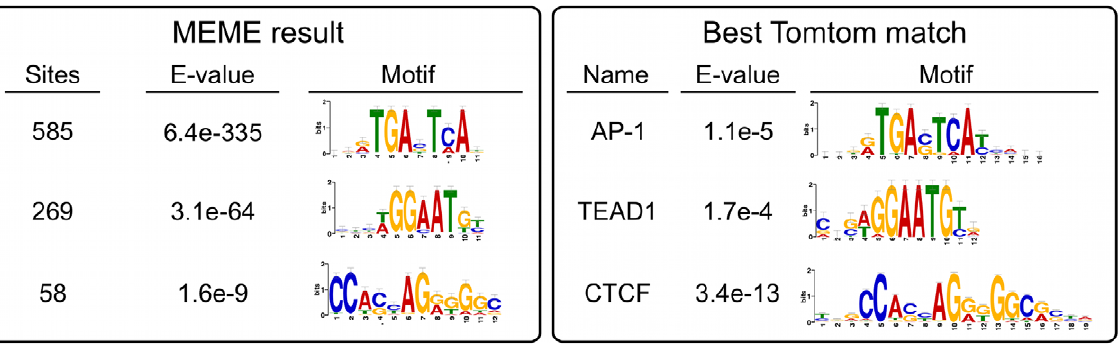
Figure 7. Non-MER85 peaks are enriched for TRE, TEAD1, and CTCF binding site motifs. ( left ) Analysis using Multiple Em for Motif Elicitation (MEME). Sequences within 50 bp of non-MER85 peak summits were submitted to MEME to identify overrepresented motifs. ( right ) Analysis using Tomtom motif comparison tool. Position specific frequency matrices for the motifs identified by MEME were submitted to TOMTOM to identify matching transcription factor binding sites. The most significant matches for each result are shown. *AP-1 motif was annotated jundm2_secondary, Jun dimerization protein 2 secondary motif (UniPROBE mouse database); TEAD1, TEA domain family member 1 (JASPAR core 2009 database); CTCF, CCCTC binding factor (JASPAR core 2009 database).